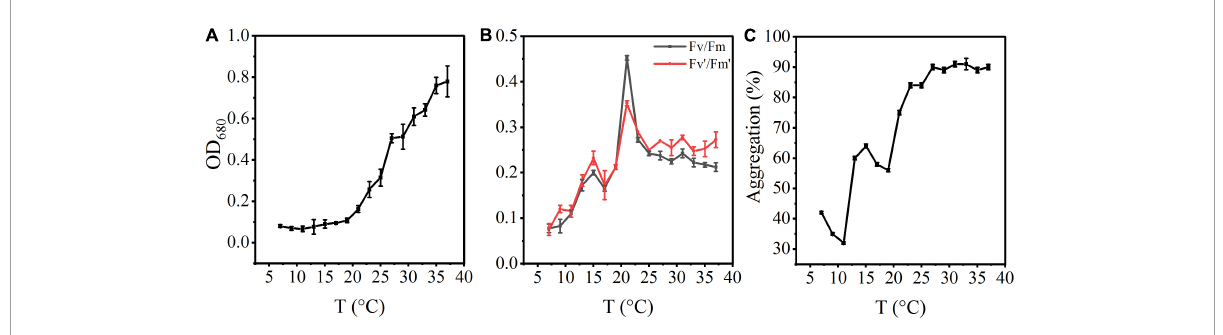
FIGURE1 Effects of rising temperature on the growth of A. flos-aquae and aggregation with temperature. (A) Variation of algal density with temperature; (B) Variation of photosynthetic activity with temperature; (C) Variation of aggregation ratio with temperature.